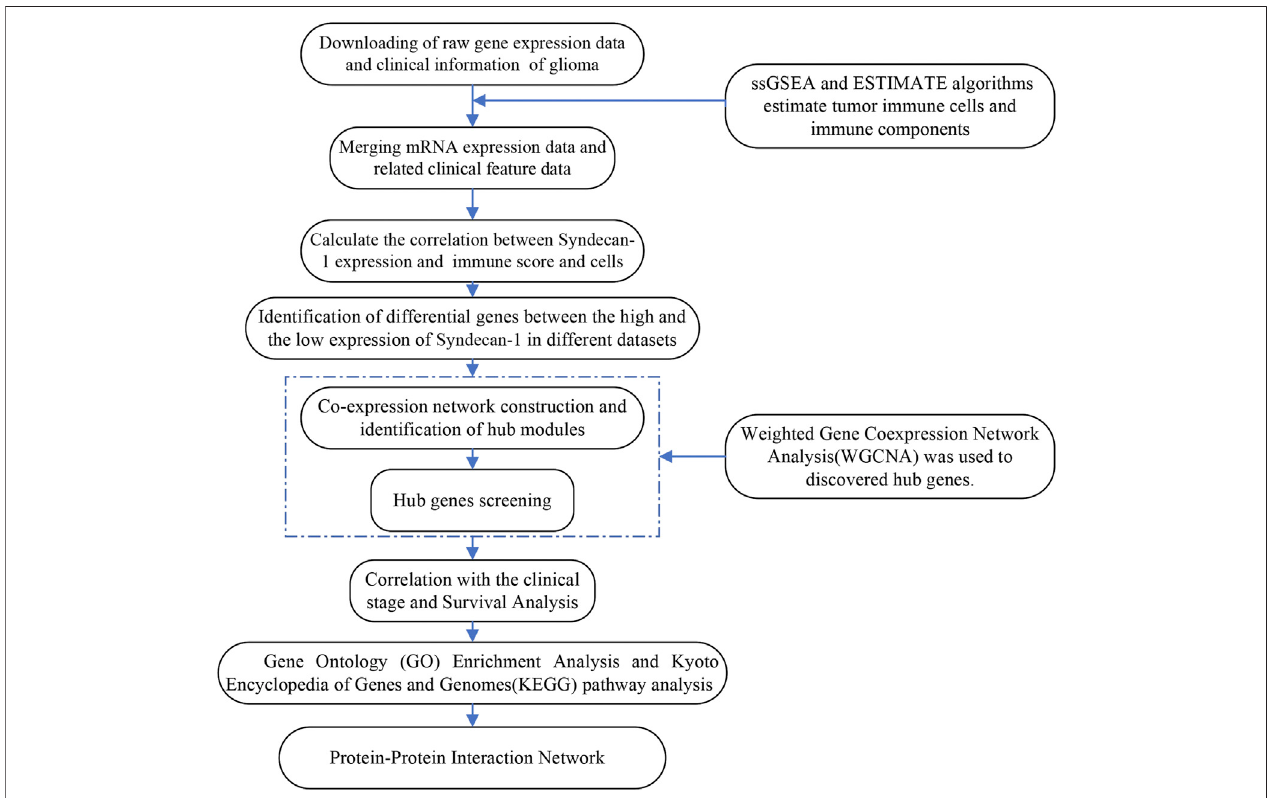
FIGURE 1 | Flow chart describing the work fl ow from collection and preparation of the data to the data